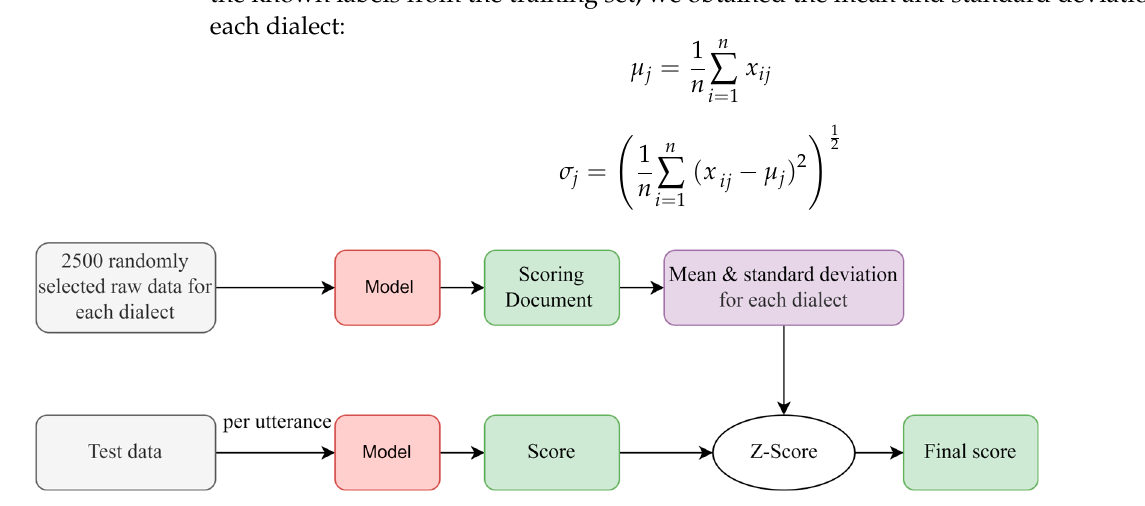
Figure 4. Z-Score process.